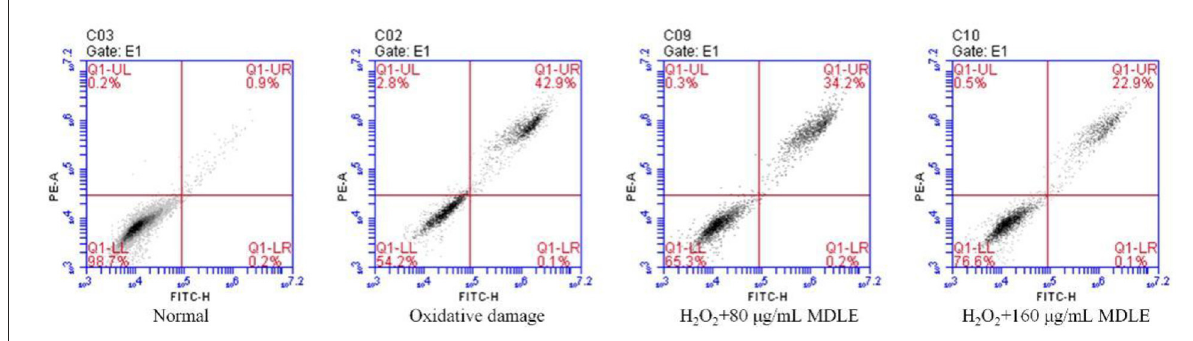
yellow molecule after combining with electrons or hydrogen free radicals. It is one of the effective means to detect the antioxidant effect of substance extracts. The in vitro evaluation